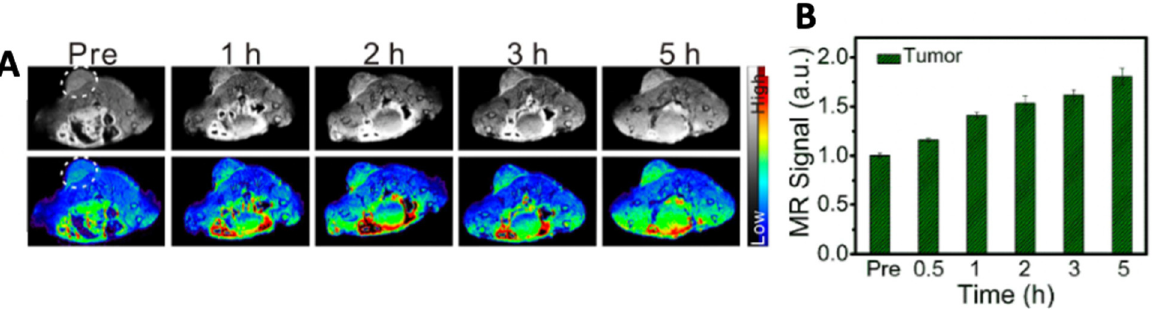
Figure 1. Representative images of ( A ) MR imaging and ( B ) its quantitative estimation. Reprinted with permission from Ref. [22]. Copyright © 2023, Elsevier.